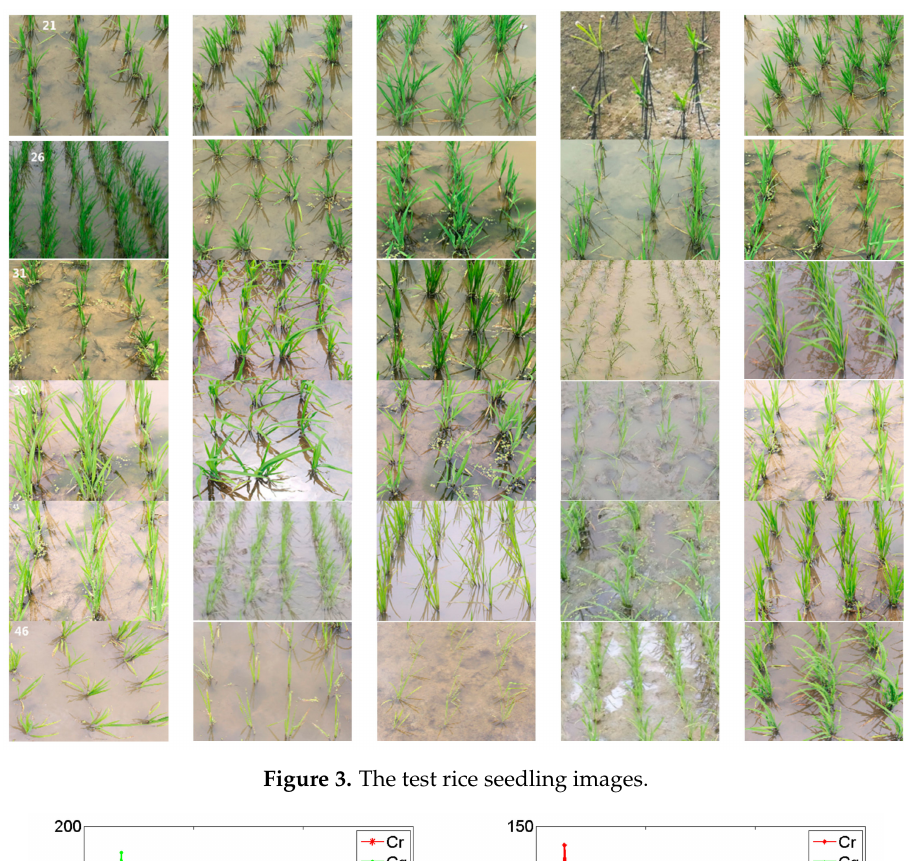
Figure 3. The test rice seedling images.